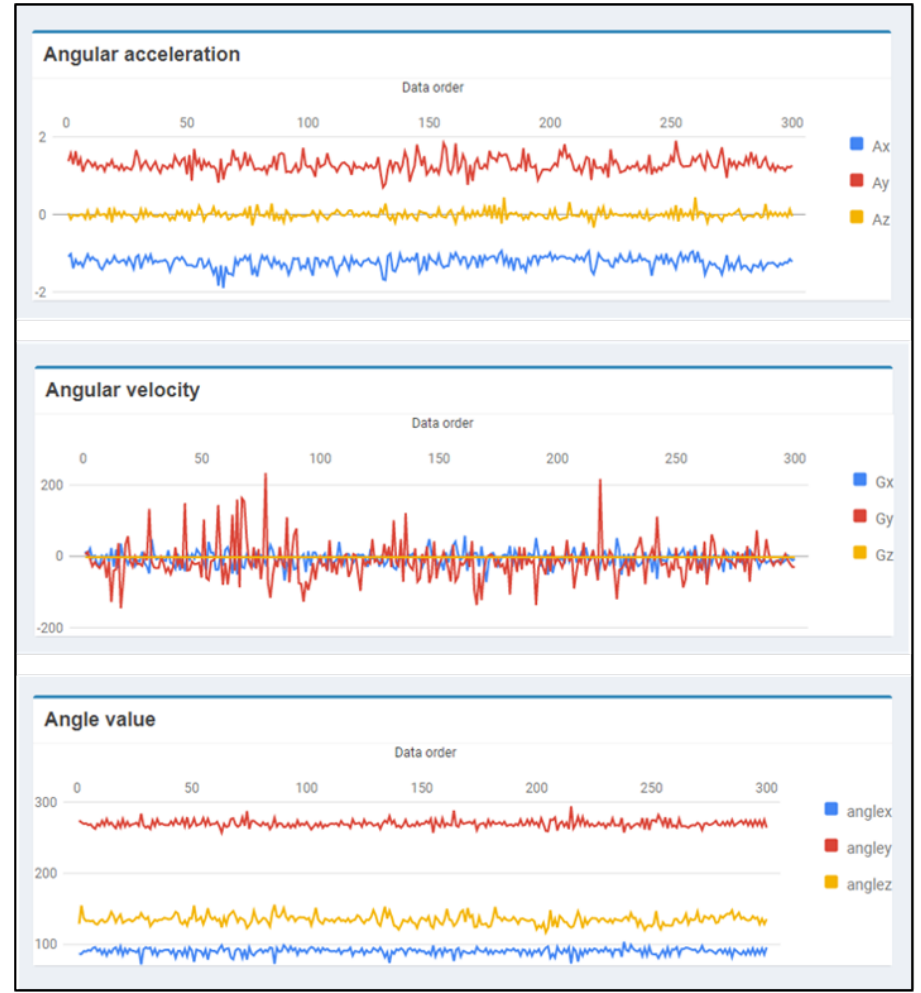
Figure 9. Example data for walking activities from